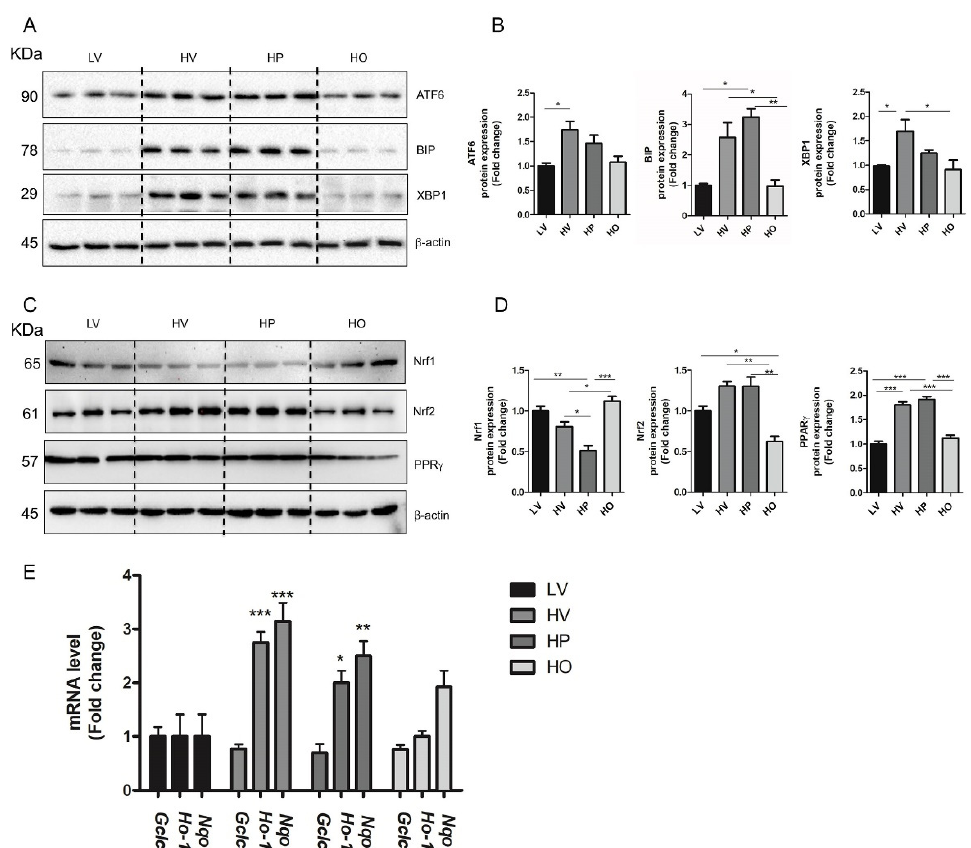
Figure 3. OEA reduces reticulum endoplasmic stress and differently affects Nrf1 and Nrf2 protein expression. ( A ) Representative immunoblots for Activating Transcription Factor 6 (ATF6), binding- immunoglobulin protein aka GRP-78 (BIP), and X-box-Binding Protein-1 (XBP1); β -actin was used as a loading control. ( B ) Quantification of protein expression. Values in the histogram were expressed as fold change relative to LV, the data represent the mean ± SEM ( n = 3). ( C ) Representative immunoblots for nuclear factor erythroid-derived 2-related factor 1 (Nrf1), Nrf2 and peroxisome proliferator- activated receptor γ (PPAR γ ); β -actin was used as a loading control. ( D ) Quantification of protein expression reported as fold change relative to the control. Values in the histogram were expressed as fold change relative to the LV, the data represent the mean ± SEM ( n = 3). ( E ) Glutamate-Cysteine Ligase Catalytic Subunit ( Gclc ), Heme oxygenase-1 ( Ho-1 ) and NAD(P)H Quinone Dehydrogenase ( Nqo1 ) mRNA expression in liver detected by RT-qPCR . Data are expressed as mean ± SEM ( n = 4). * p < 0.05; ** p < 0.005; *** p <